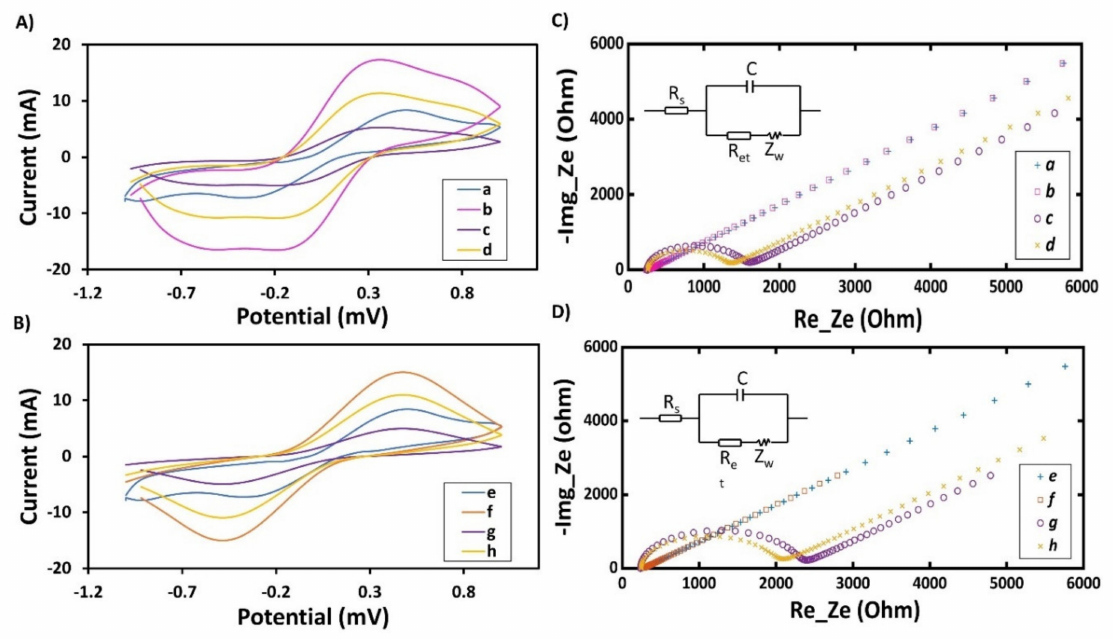
Figure 3. ( A ) and ( B ) CV curves, ( C ) and ( D ) EIS spectra of the stepwise modified electrode in 5 mM [Fe(CN)6]3 / 4- aqueous solution containing 0.1 M KCl: ( a ) bare (in blue), ( b ) bare / AgNPs (in fuchsia), ( c ) bare / AgNPs / MB-aptamers (in purple), ( d ) bare / AgNPs / MB-aptamers / cDNA (in yellow), ( e ) bare (in blue), ( f ) bare / CNTs (in orange), ( g ) bare / CNTs / MB-aptamers (in purple), ( h ) bare / CNTs / MB-aptamers / cDNA (in